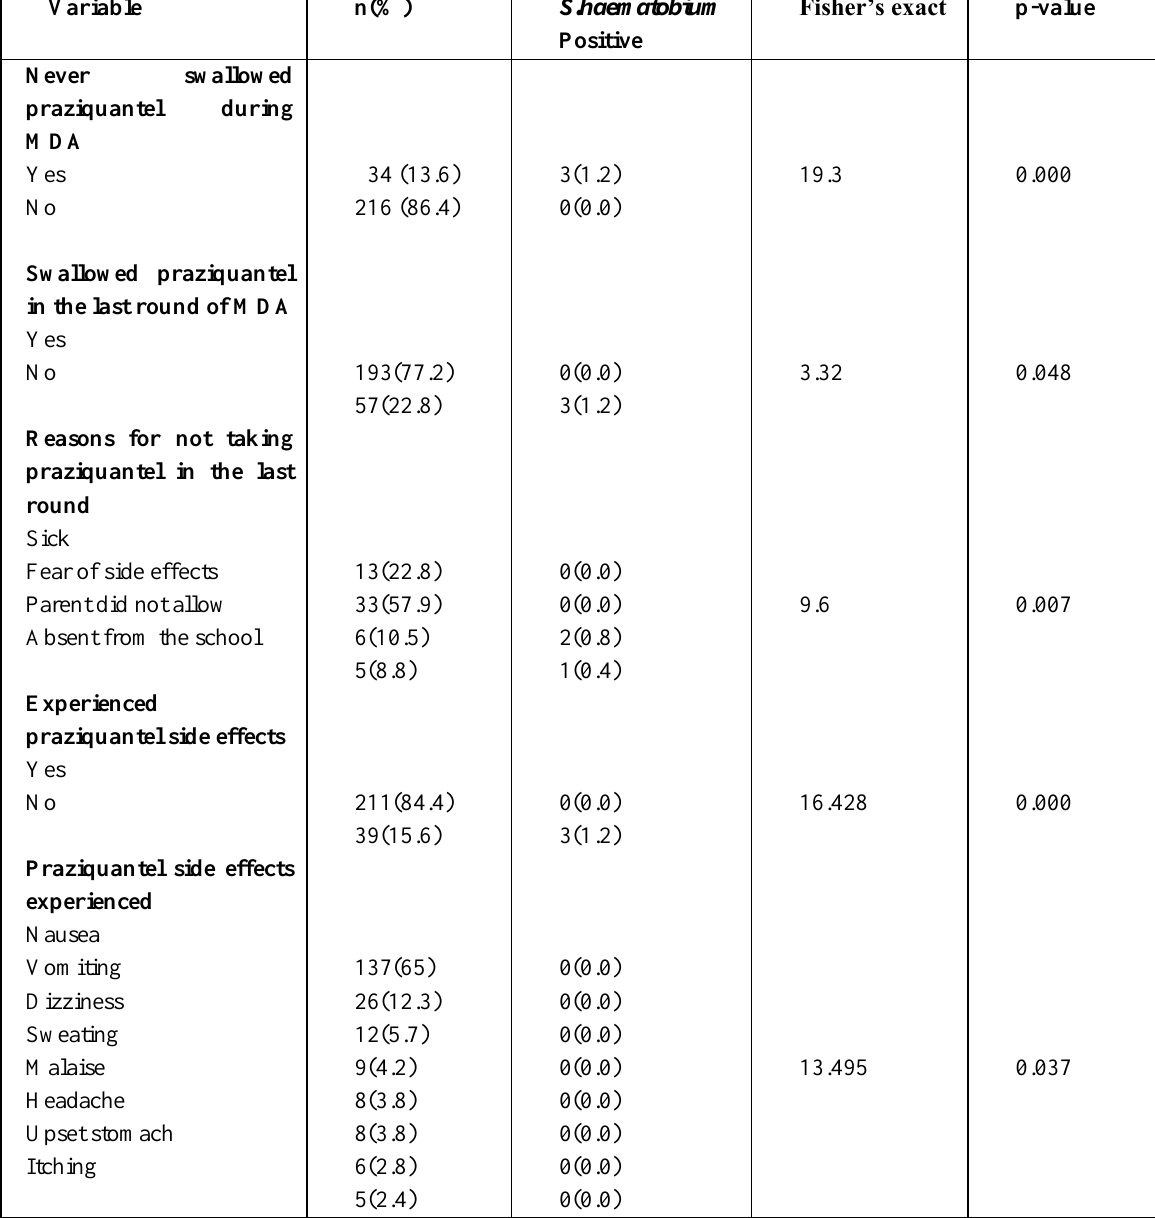
Table 5. Self-reported uptake of praziquantel in the last round of MDA (n=250).